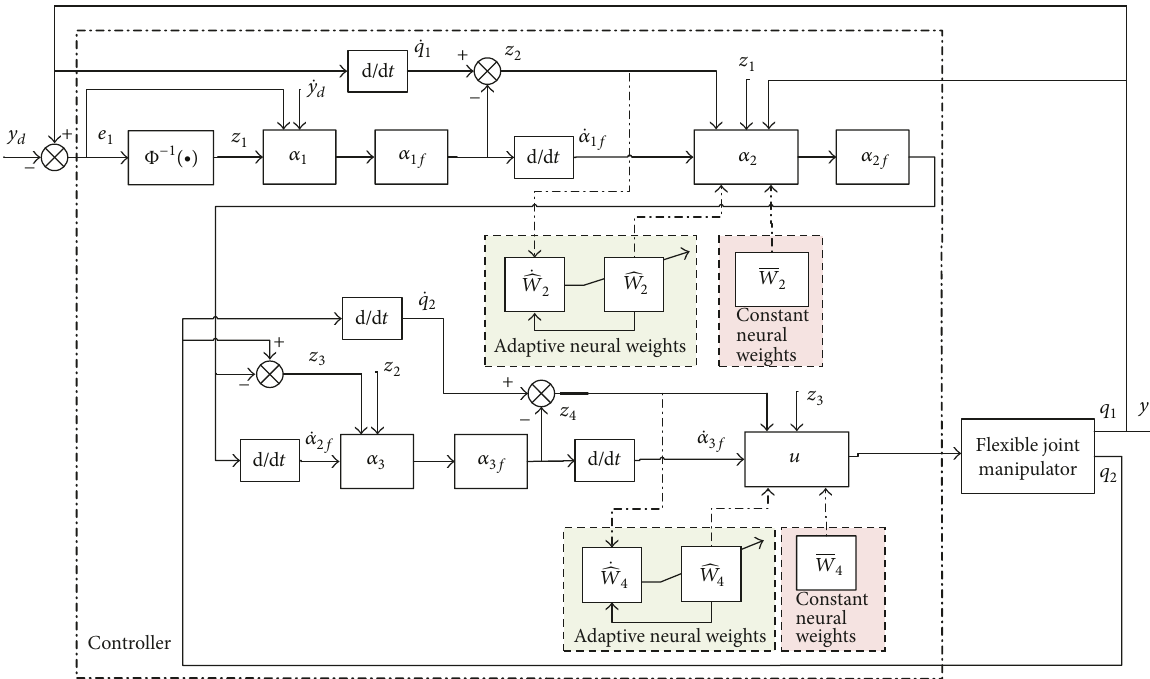
Figure 2: Block diagram of the proposed learning control